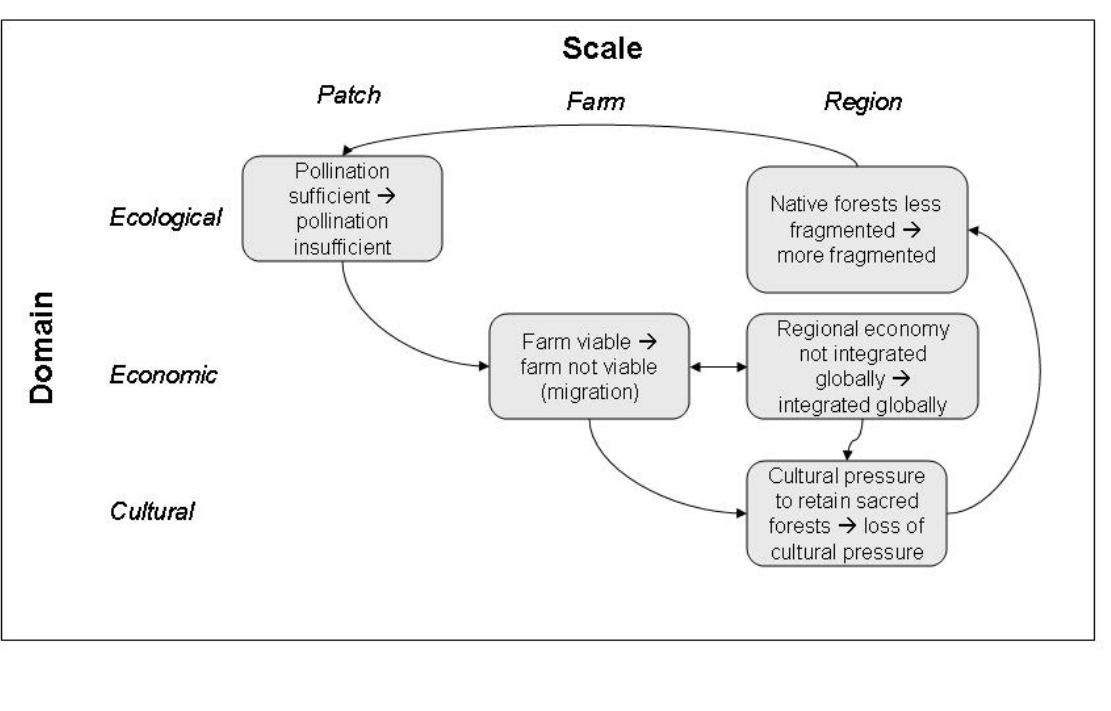
Fig. 10 . The key threshold interactions in the Madagascar dry forest case in the three domains and at three